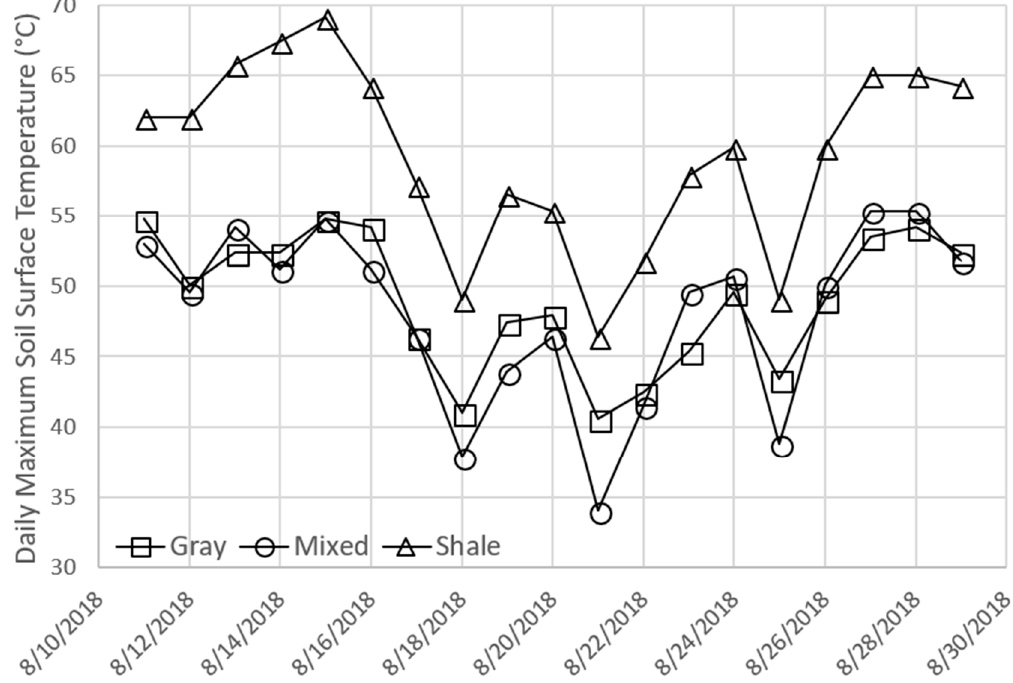
Figure 6. Daily maximum soil surface temperature, plotted for Gray, Mixed, and Shale (No data were available for Brown due to logger damage).